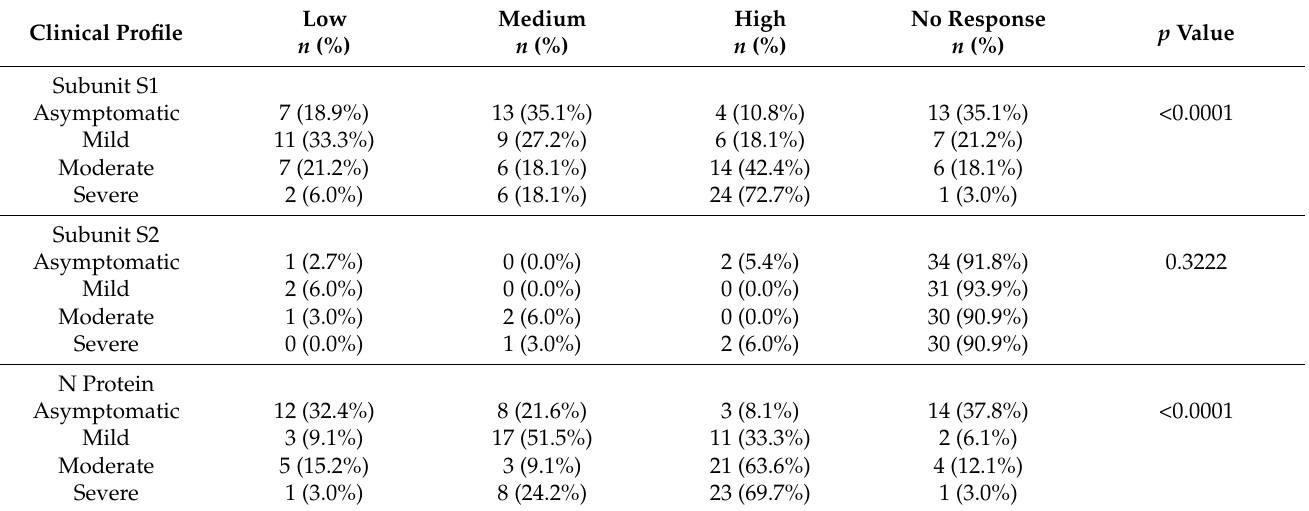
Table 2. IgG antibody response to the S (S1 and S2) and N proteins in individuals with different clinical profiles of